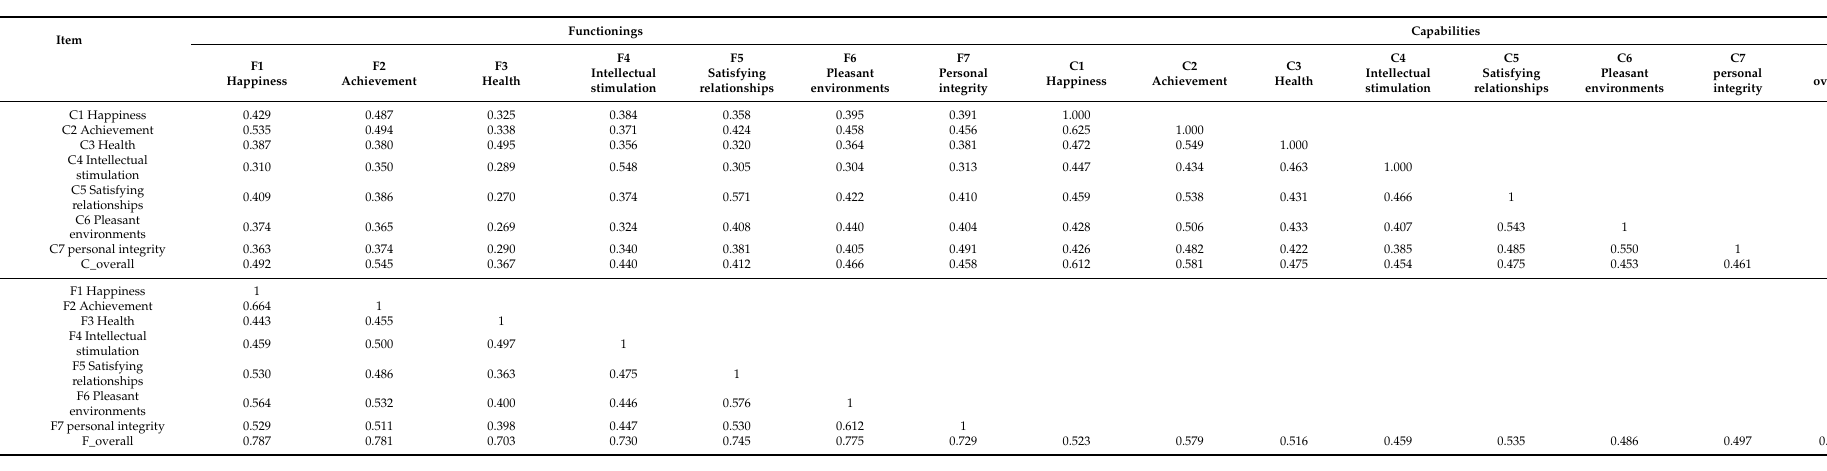
Table 3. Spearman correlation matrix of capability (C) and functioning (F) items among and between each other (all correlations significant at p <